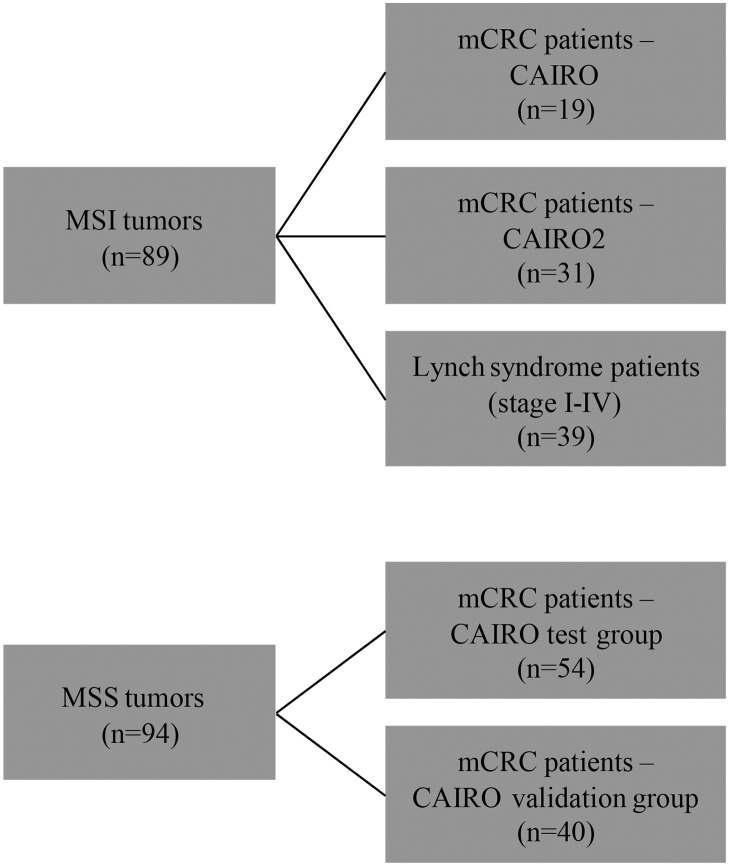
Flowchart of selected CRC patients to determine the frequency and prognostic value of EMAST.